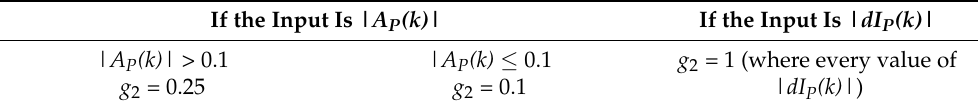
Figure 6. INC-MPPT algorithm with fuzzy logic.